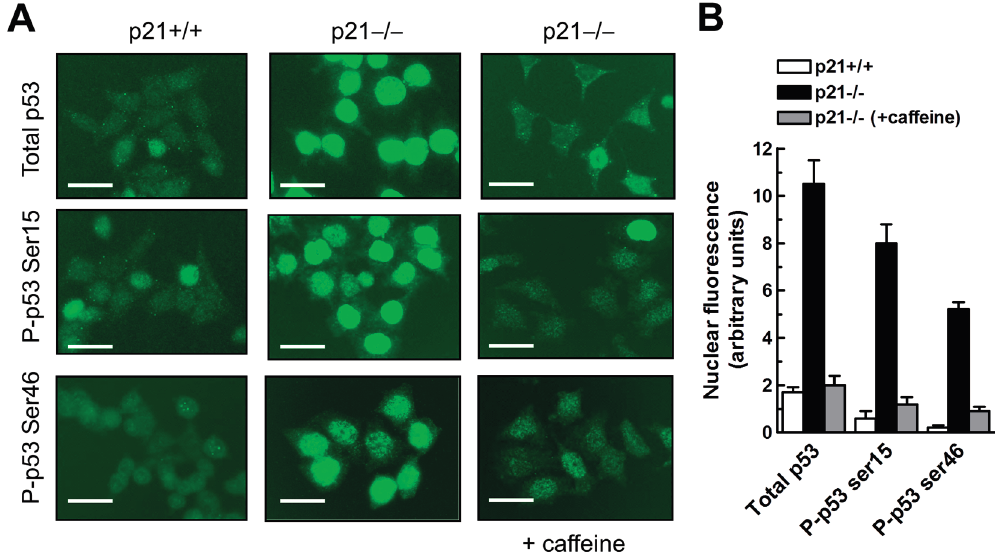
Figure 2. Immunofluorescence analysis of p53 protein levels and phosphorylation status in HCT116p21+/+ and HCT116p21 − / − cultures before and after incubation with caffeine (4 mM; 24 h). ( A ) Representative images showing phosphorylation and nuclear localization of p53 in HCT116p21 − / − cultures and suppression of these effects by caffeine; scale bar, 20 µm; ( B ) Densitometric evaluation of intensities of nuclear fluorescence staining. Bars, SE. 2.2. Loss of p21 in HCT116 Cells Is Associated with Accumulation of DNA Double-Strand Breaks (DSBs) The presence of cells with high numbers of γ H2AX foci within HCT116p21 − / − cultures suggests the spontaneous accumulation of DNA DSBs. We used the neutral comet assay to further test this notion. In this assay, the appearance of a comet tail is presumed to reflect the presence of DSBs [36].